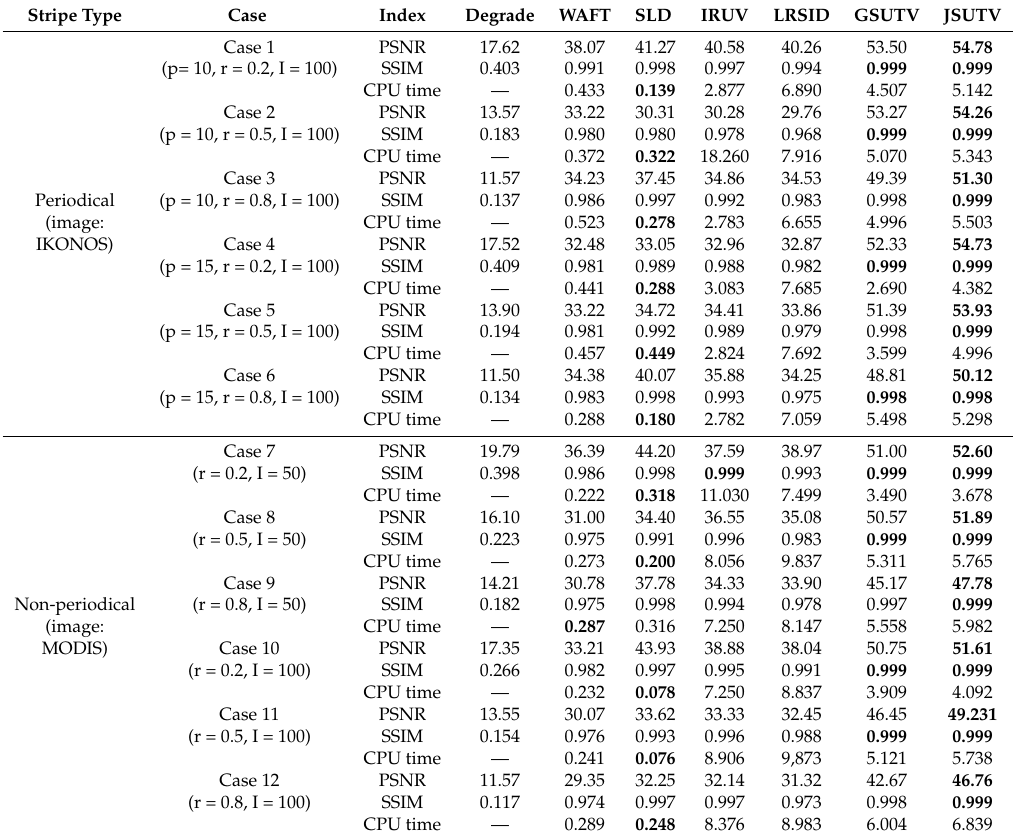
Figure 9. Column mean cross-track profiles of Figure 5. Column mean cross-track profiles’ comparison between the original image and the estimated stripe by: ( a ) WAFT; ( b ) SLD; ( c ) IRUV; ( d ) LRSID; ( e ) GSUTV; and ( f ) JSUTV. Table 2. Quantitative results (PSNR (dB), SSIM values, and CPU time) of the simulated experiments. Stripe